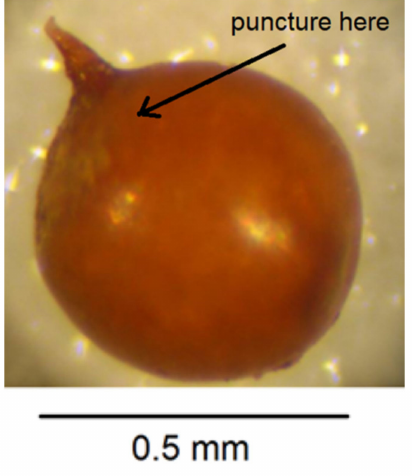
Figure 4. Puncture cyst wall to release pressure.